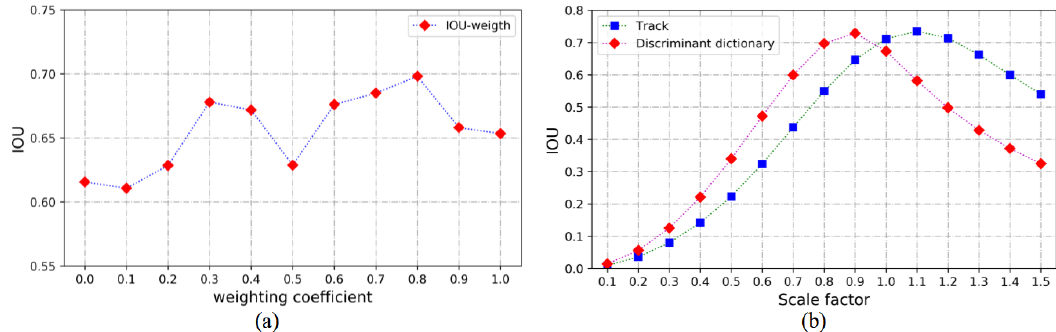
Figure 9. ( a ) Average IOU vs. the weight coefficient of the prior center. ( b ) Average IOU vs. the scale scaling